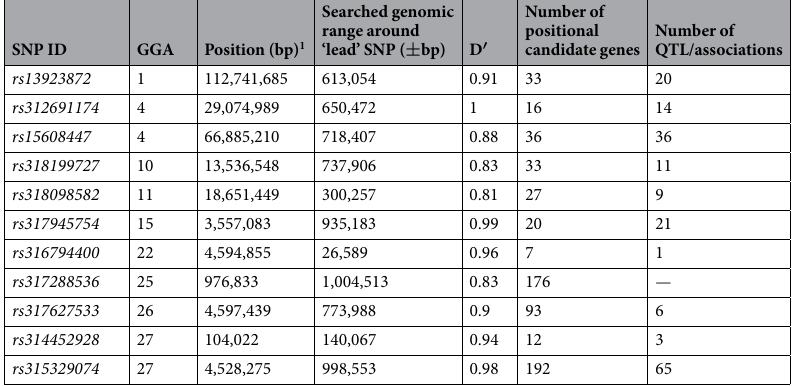
Table 2. Number of positional candidate genes and QTL/associations within the searched genomic regions ( ± maximum distance of the farest SNP being in strong LD (D ′ > 0.8) with the lead SNP; D ′ : average D ′ values within the searched genomic region). 1 Positions are based on Gallus gallus-5.0 genome